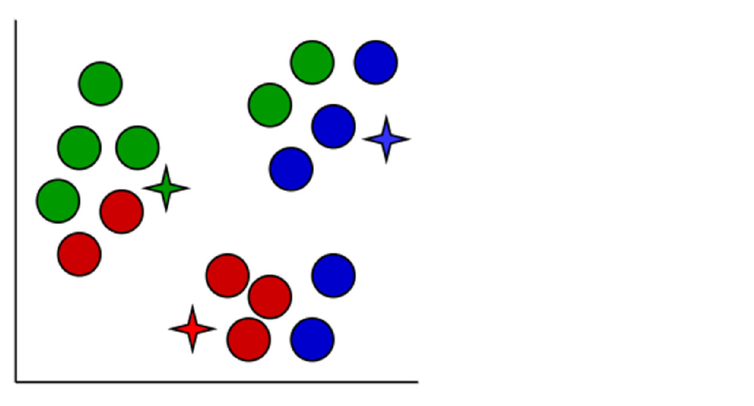
Figure 8. Step 5— K ‐ means: K = 3 Step 5: Measure the average of data entities in each cluster and relocate the centroid.